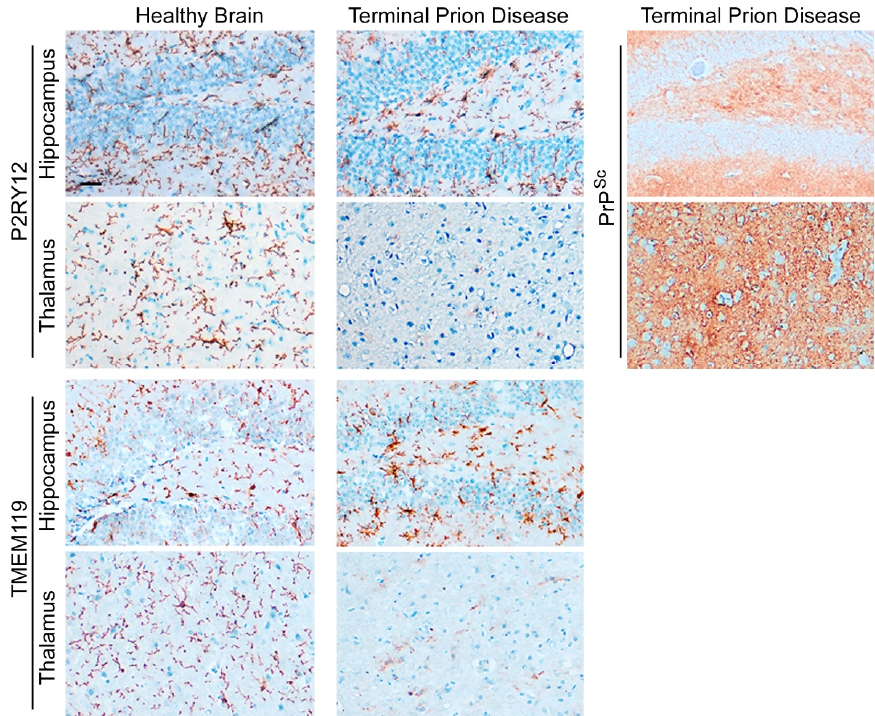
Figure 4. Loss of microglial homeostatic phenotype in terminal prion disease. The microglia- specific homeostasis markers P2RY12 and TMEM119 show a ramified morphology of microglia in the healthy brain [47,73,97]. In terminal prion disease, this homeostatic microglia signature is lost in a region-dependent manner [47,73,97]. While the activated microglia in the dentate gyrus of the hippocampus display a bushy morphology with thick and retracted processes and still express both markers, microglia in the thalamus (posterior complex) have almost completely lost the expression of the markers, especially P2RY12. In the RML-prion mouse model, the deposition of PrP Sc -specific staining is stronger in the thalamus than in the hippocampus in terminal prion disease. Scale bar: 25 µm.